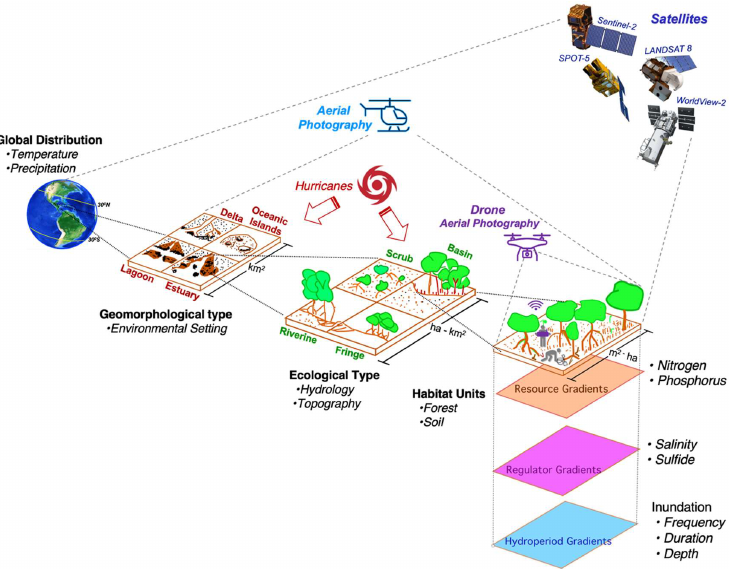
Figure 2. Hierarchical classification for mangrove-dominated ecosystems describing abiotic controls on mangrove structural and functional properties at the global (temperature, precipitation), regional (geomorphology), and local scale (ecotype habitats) in the neotropics. Environmental factors in each spatial-level control processes determine soil properties, fertility gradients, and mangrove produc- tivity. Remote sensing coverage and aerial photography are also shown at different spatial scales (modified from [16]). Satellite photo credits: SPOT-5 image credit: CNES [119]; Sentinel-2 [120]; LANDSAT 8 [121]; WorldView-2 [122].